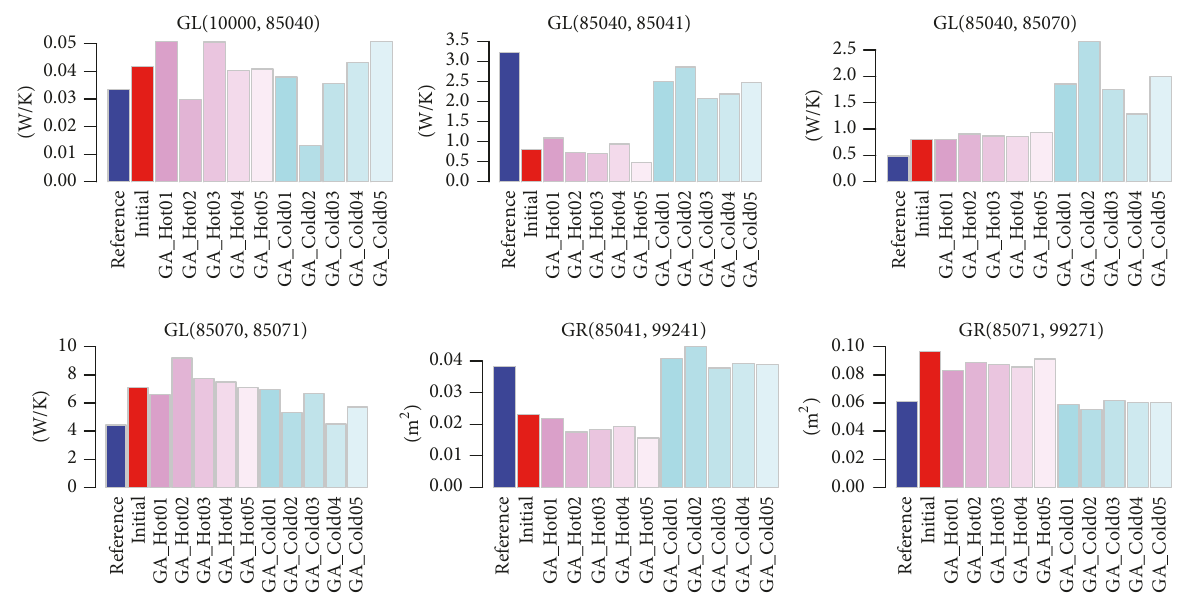
Figure 5: Steady-state GA. Variable values obtained from